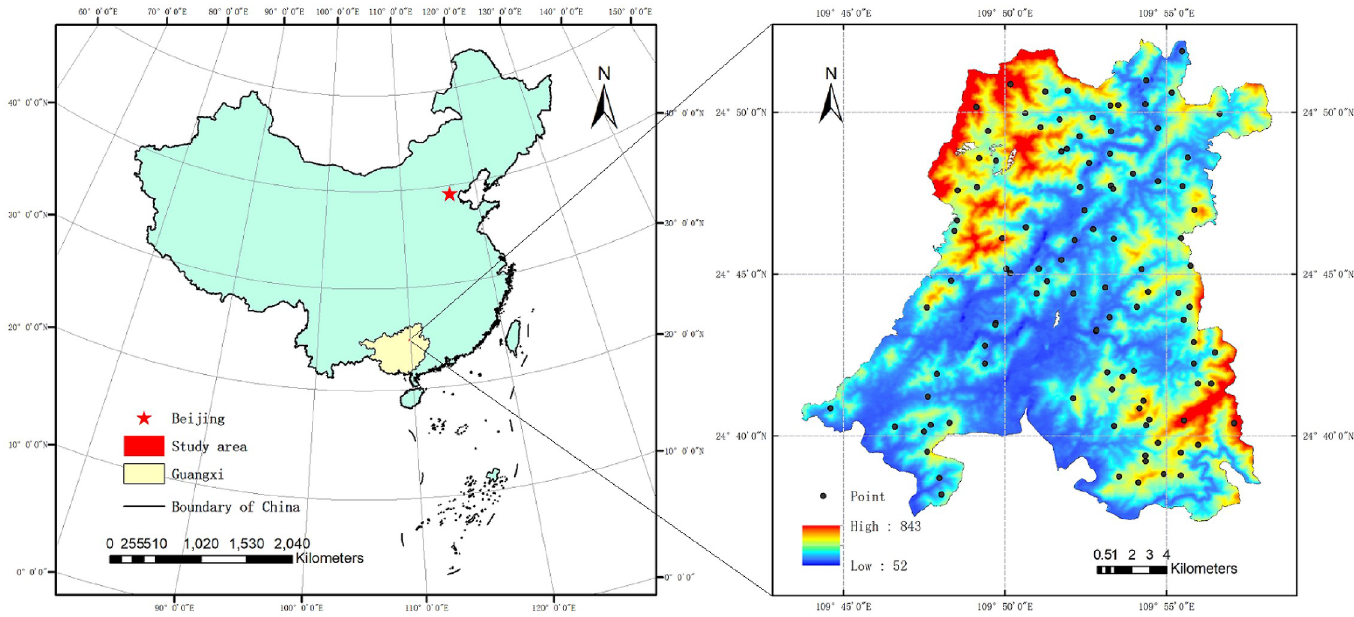
Fig 1. Location of study area and distribution of soil sampling